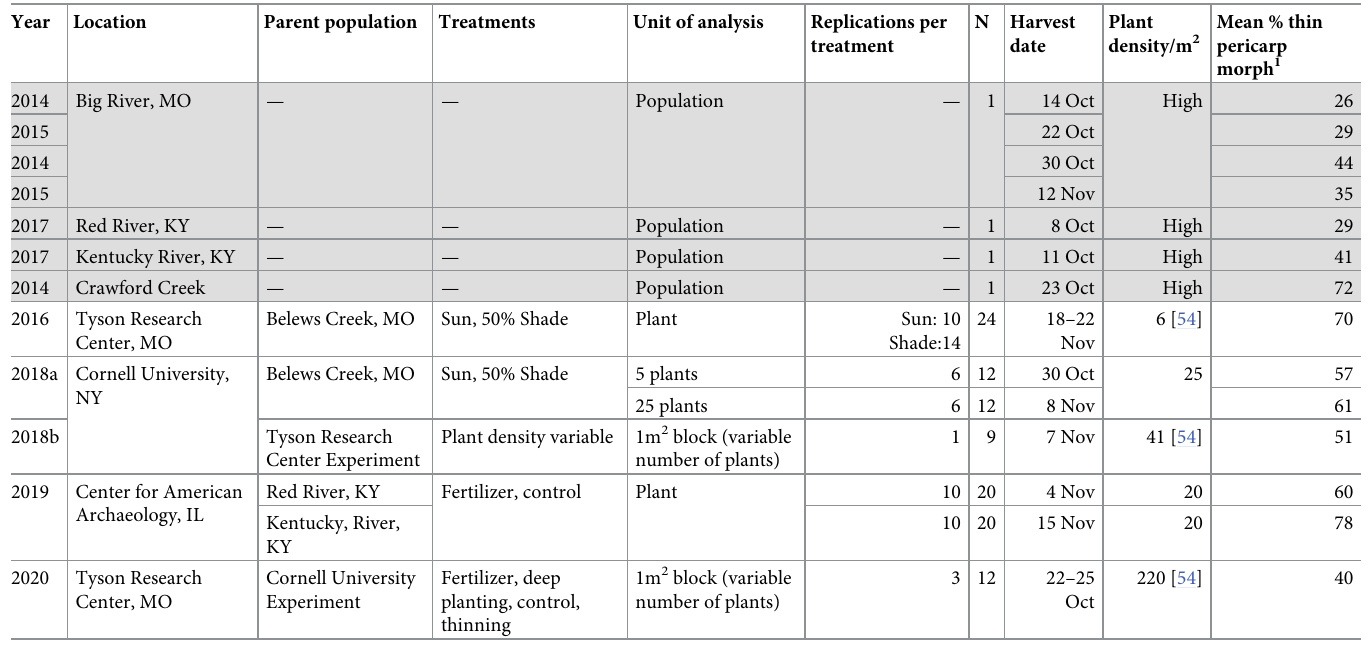
Table 2. Harvest date, plant density and frequency of thin pericarp morphs in erect knotweed harvests Free-living parent populations are